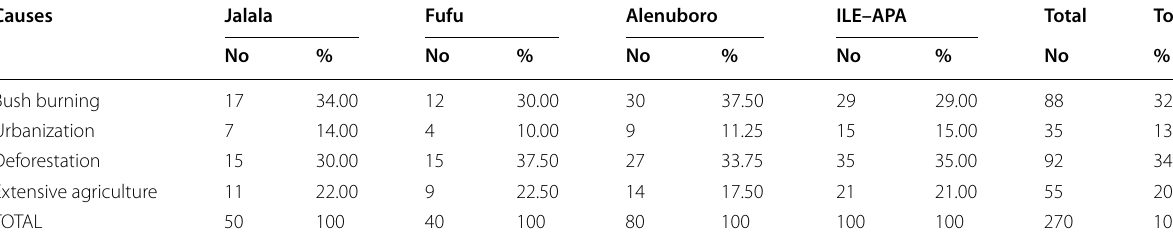
Table 4 Rural women’s awareness as regards the causes of climate change